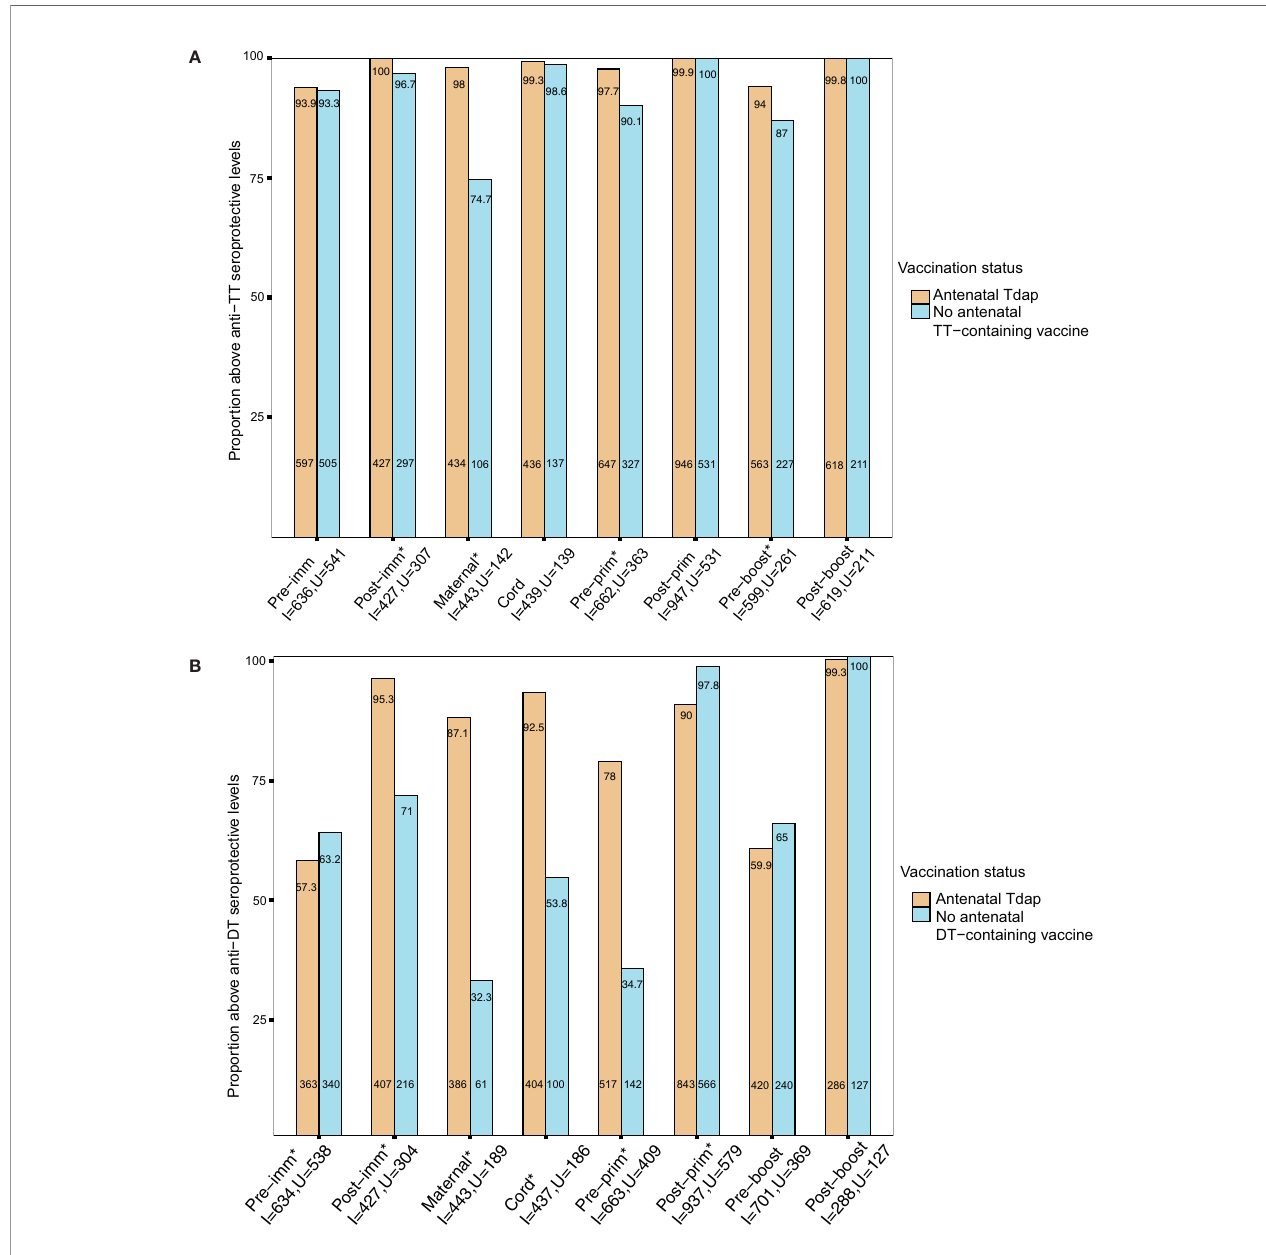
FIGURE 5 | (A) Seroprotection rates against tetanus diseases. Rates of participants with anti – tetanus toxoid (TT) IgG ≥ 0.1 IU/mL in women immunized with tetanus- diphtheria-acellular pertussis (Tdap) versus women who did not receive Tdap, diphtheria and tetanus toxoids (dT), or TT vaccine in pregnancy pre-immunization, post-immunization and at delivery; in infants born to women immunized Tdap versus infants of women not immunized with Tdap, dT or TT vaccine in pregnancy pre- primary, post-primary, pre-booster and post-booster immunization with diphtheria-tetanus-acellular pertussis vaccine (*comparisons with p-values <0.05). P-values: Pre-imm: p=0.806; Post-imm: p = 0.001 ; Maternal: p<0.001 ; Cord: p = 0.754; Pre-prim: p<0.001 ;Post-prim: p =1; Pre-boost: p=0.001 ;Post-boost: p =1. (B) Seroprotection rates against diphtheria diseases. Rates of participants with anti-DT IgG ≥ 0.1 IU/mL in women immunized with tetanus-diphtheria-acellular pertussis (Tdap) versus women who did not receive Tdap or dT vaccine in pregnancy pre-immunization, post-immunization and at delivery; in infants born to women immunized Tdap versus infants of women not immunized with Tdap or dT vaccine in pregnancy pre-primary, post-primary, pre-booster and post-booster immunization with diphtheria-tetanus-acellular pertussis vaccine (*comparisons with p-values < 0.05). P-values: Pre-imm: p=0.045 ; Post-imm: p<0.001 ; Maternal: p<0.001 ; Cord: p<0.001 ; Pre-prim: p<0.001 ; Post-prim: p<0.001 ; Pre-boost: p=0.116; Post-boost: p=0.863. Seroprotection rates were compared using the chi- squared test. Pre-imm, pre-immunization; Post-imm, post-immunization; Pre-prim, pre-primary; Post-prim, post-primary; Pre-boost, pre-booster; Post-boos, post- booster; I, immunized; U, Unimmunized. Absolute numbers are shown in the bottom and percentages in the top of the